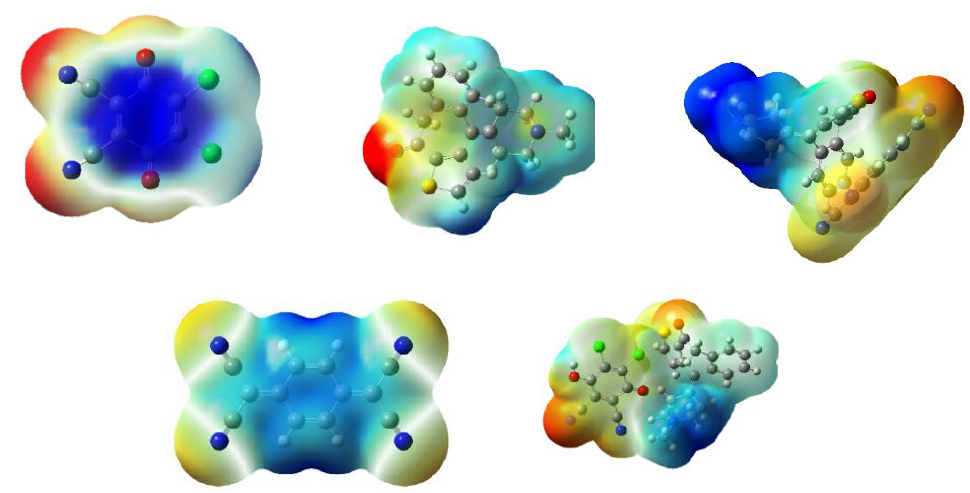
Figure 9. Molecular electrostatic potential maps of KT, DDQ, TCNQ, KT → DDQ and KT → TCNQ (the red color represents maximum negative area or a favorable site for an electrophilic attack, the blue color indicates the maximum positive area or a favorable site for a nucleophilic attack, and the green color represents zero potential area).